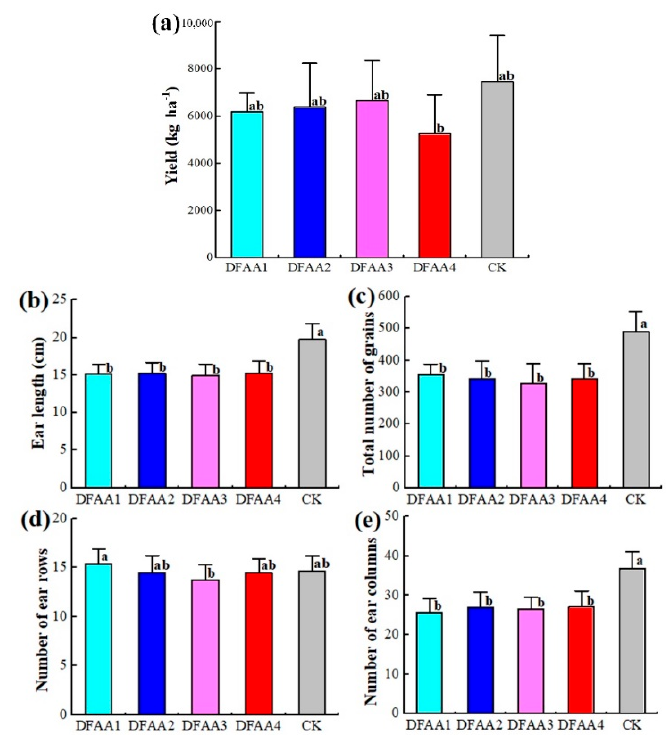
Figure 6. The parameters of summer maize grain yield at harvest. ( a ) yield; ( b ) ear length; ( c ) total number of grains; ( d ) number of ear rows; ( e ) number of ear columns. Error bars represent standard deviations ( n = 6), different letters indicate significant difference among the treatments at 0.05.